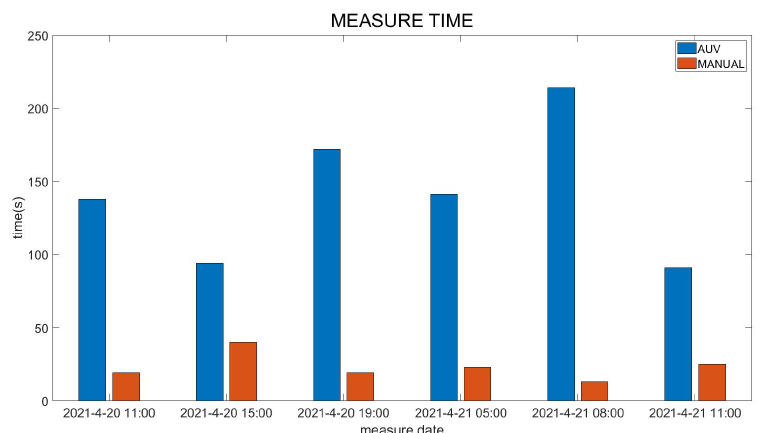
Figure 21. AUV and MANUAL measurement time comparisons.